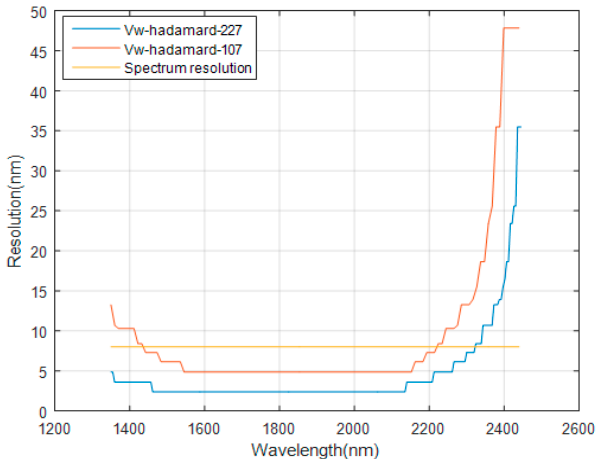
Figure 15. Digital micromirror device (DMD) resolution of the new Hadamard and the traditional Hadamard. The blue and red curves are obtained by the V W -Hadamard mask. The yellow curve is the spectral resolution which is the same as the DMD resolution of the traditional Hadamard.